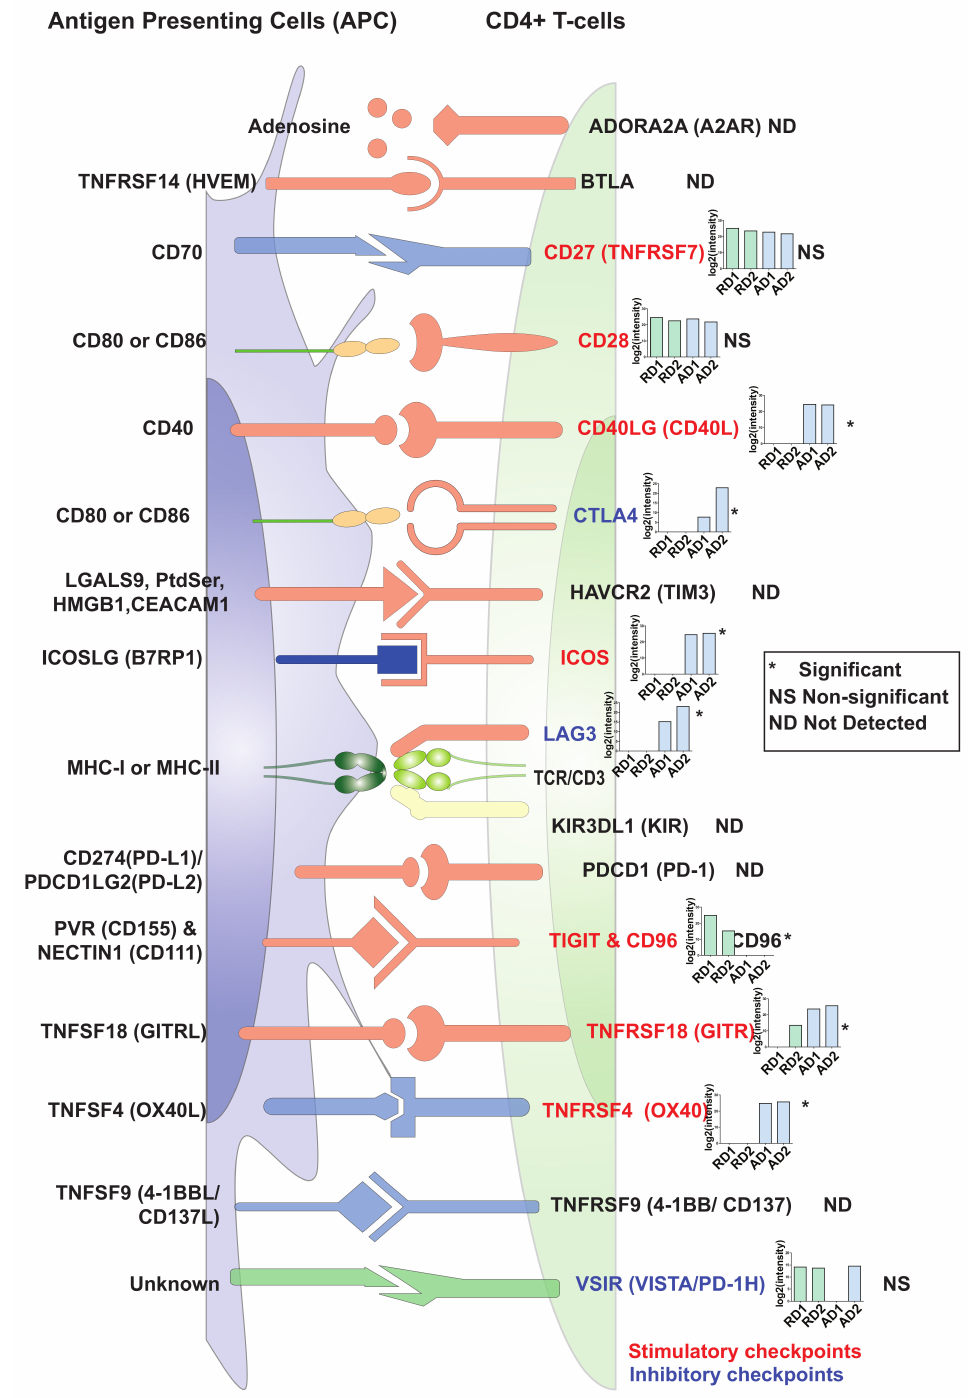
Figure 5. An illustration representing expression profiles of immune checkpoint regulators in resting and activated primary CD4+ T cells. The inset graphs for each protein provide log2(intensity) value-based abundances for resting (R) and CD3/CD28-activated (A) CD4+ T cells from Donor1 (D1) and Donor2 (D2). Legends indicate Significant (*, FDR ≤ 0.05), Not significant (NS), Not detected